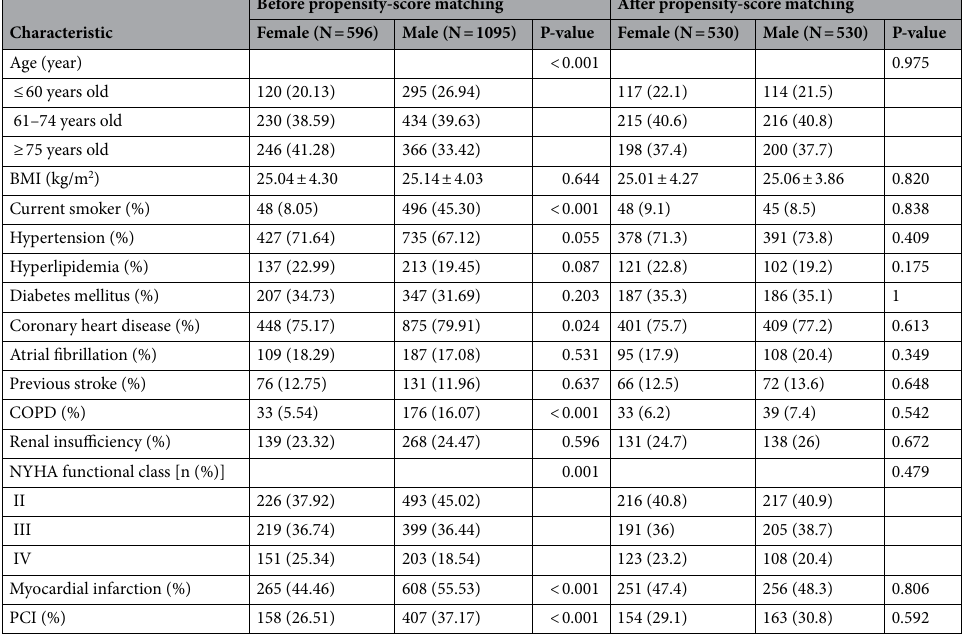
Table 1. Baseline characteristics before and after propensity-score matching. Values are mean ± SD or %. BMI body mass index, COPD chronic obstructive pulmonary disease, NYHA New York Heart Association, PCI percutaneous coronary intervention, CV event cardiovascular event (cardiovascular death or heart failure